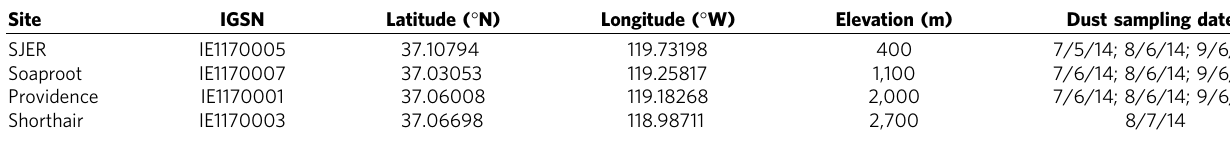
Table 1 | Study site locations and dust sampling dates. Site IGSN Latitude ( (cid:2) N)